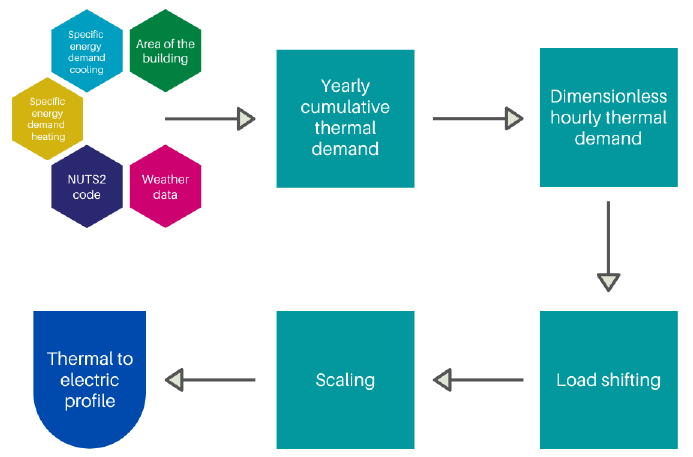
Figure 4. Scheme of the simplified method used to calculate the heat pump electric consumption